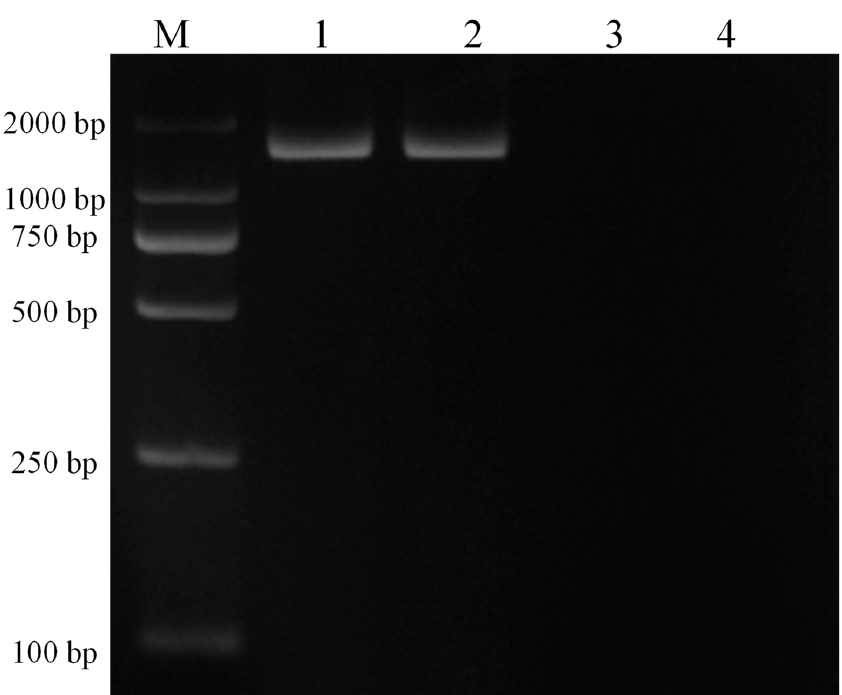
Figure 3. PCR amplification of 18S RNA with genus-specific primers for confirmation of piroplasm infection in experimental animals and the established cell line. Here, M represents the DNA marker (DL2000), lane 1 depicts the experimentally infected cattle with sporozoites, lane 2 depicts the transformed cells, lane 3 depicts the piroplasm free cattle, and lane 4 depicts the negative control.